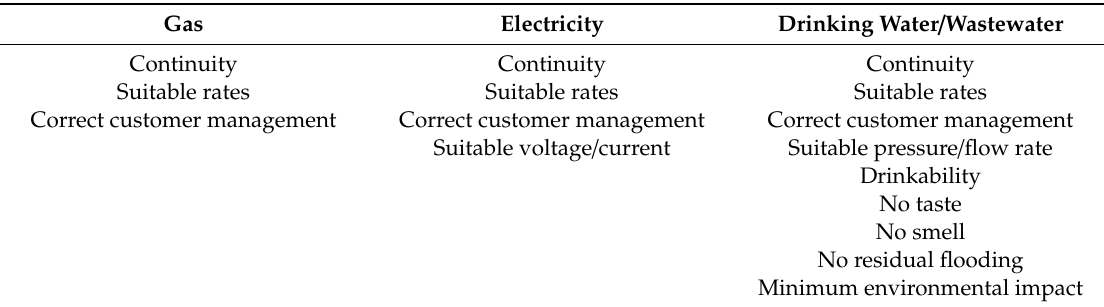
Table 4. Users expectations in gas, electricity, and drinking water or wastewater